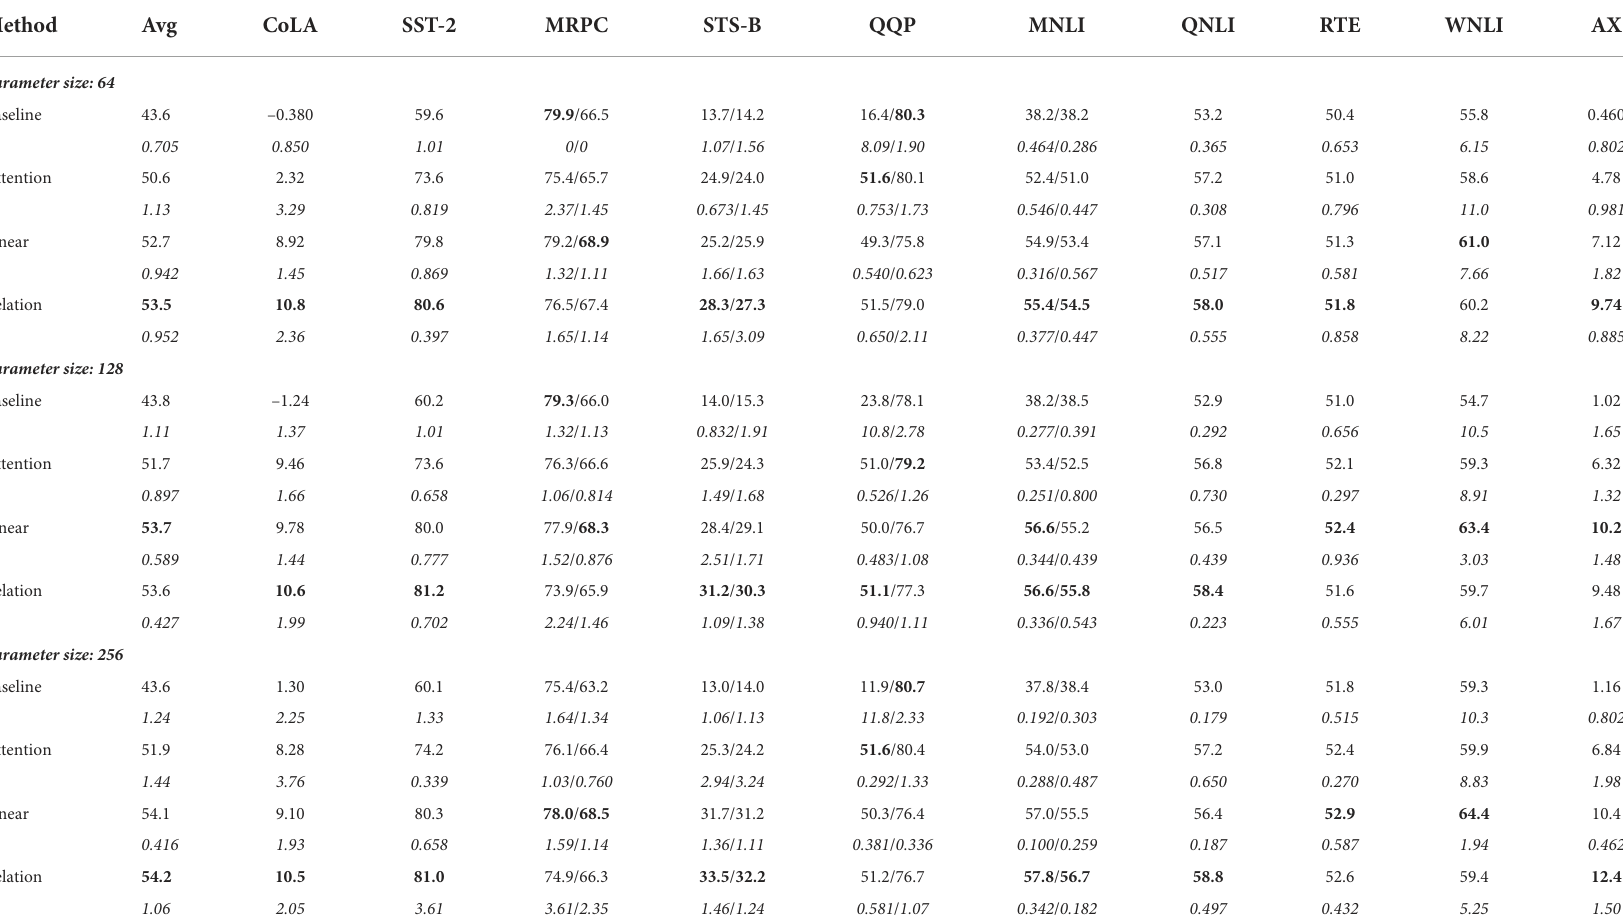
The number to the right of “Parameter size” denotes the depth of Attention, Relation, or MLP. “Linear” denotes Linear Attention. For MNLI, accuracy on MNLI-m and MNLI-mm are reported. For MRPC and QQP, accuracy and F1 are reported. For